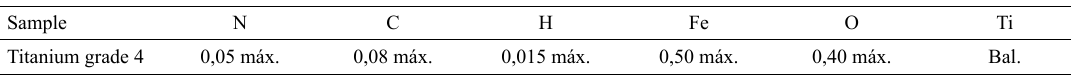
Table 1. Chemical composition of cp-Ti grade 4 (in % weight) 13 Sample